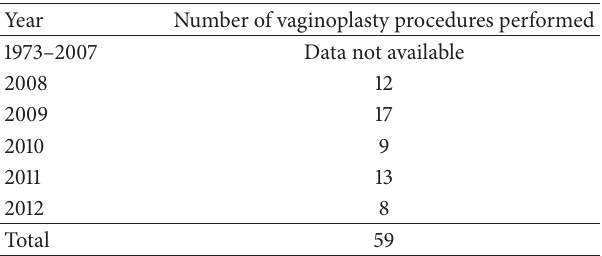
Table 2: Ratio of the Thai/Foreign MTF transsexual patients operated in